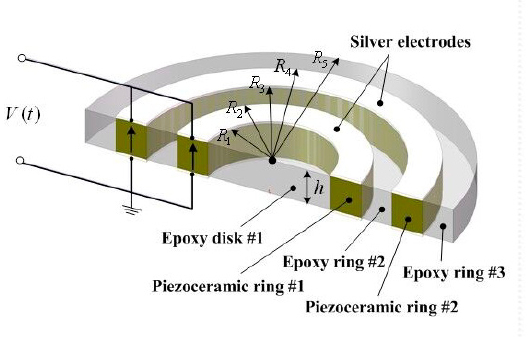
Figure 1. Schematic representation of the radially layered cylindrical piezoceramic/epoxy composite transducer.